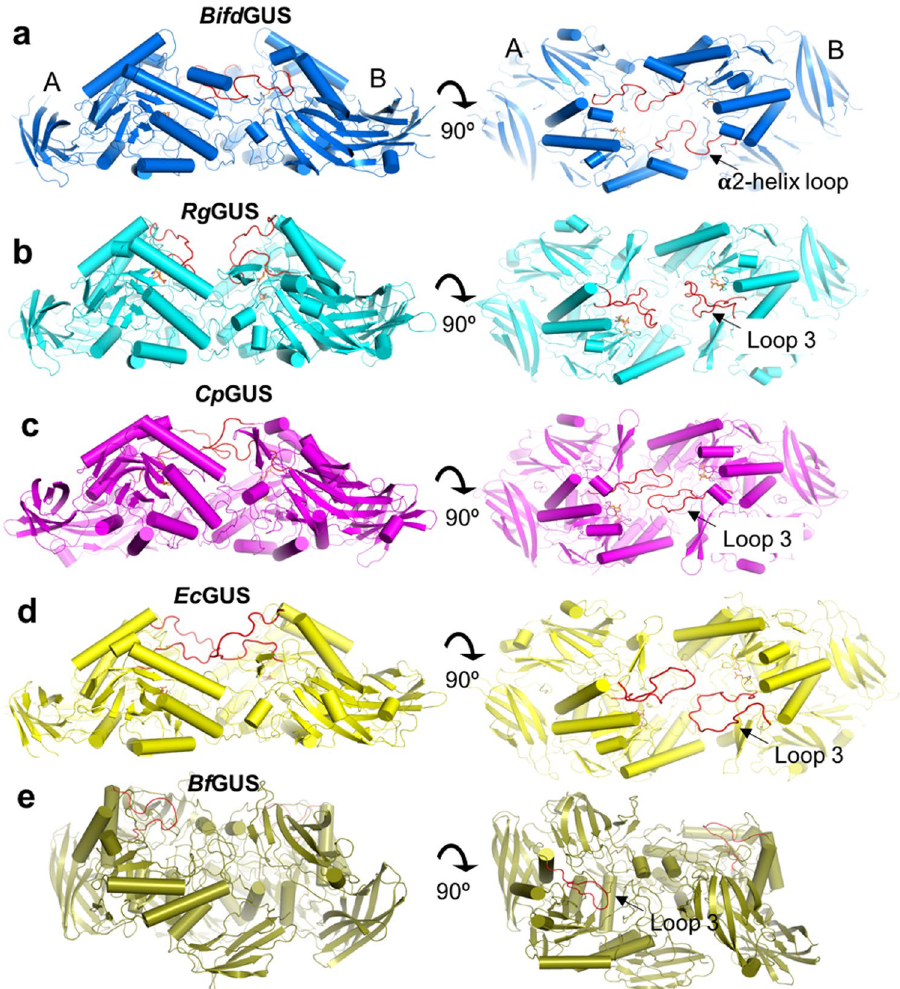
Figure 3. Comparison of the dimeric structures of the five gut bacterial GUSs. Top and side views of the dimers of the tetrameric ( a ) Bifd GUS, ( b ) Rg GUS, ( c ) Cp GUS ( d ) Ec GUS and ( e ) Bf GUS. The highlighted loops (red) are located either at the periphery of the TIM barrel (loop 3) or at the jelly-roll domain ( α 2-helix loop). ( a ) Each α 2-helix loop in Bifd GUS stretches to the ABS of the adjacent subunit. Each loop 3 of Cp GUS ( c ) and Ec GUS ( d ) exists in an open form and extends from its own subunit to the ABS of the adjacent subunit. Conversely, both loops 3 are not in contact with the adjacent subunit in Rg GUS ( b ). The dimeric interface of Bf GUS ( e ) is oriented differently than in the other GUSs as the active site of the two monomers do not face each other. See also Supplementary Fig. S2. Structural representations were prepared with the use of the Pymol Molecular Graphics System (version 1.8.4.0